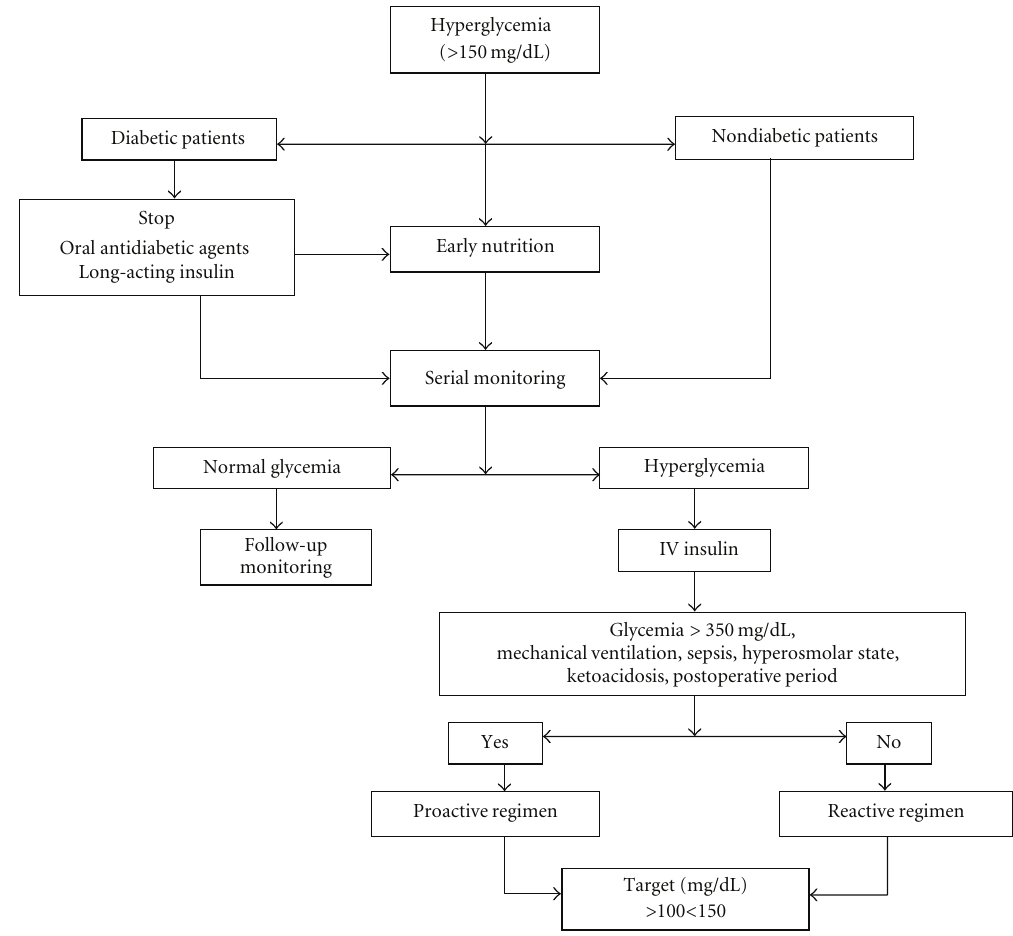
Figure 3: Algorithm proposed for hyperglycemic